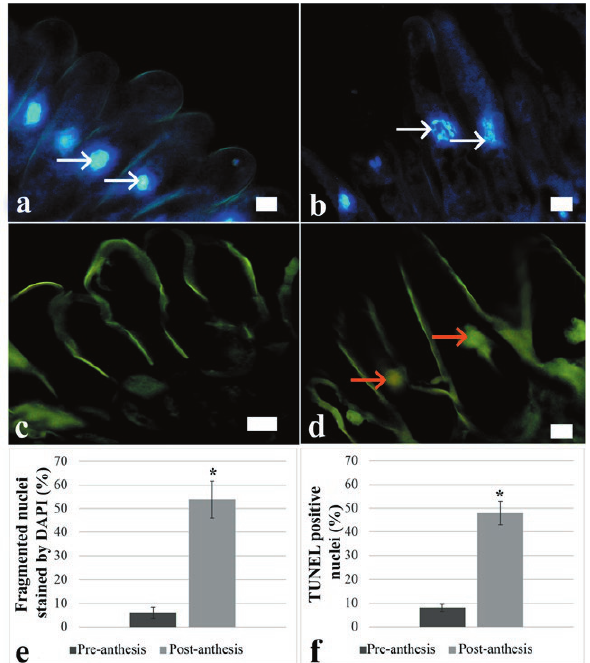
Figure 3. Analysis of nuclear DNA fragmentation. a DAPI stained spherical nuclei at pre-anthesis. b DAPI stained degenerated nuclei at post-anthesis. c TUNEL negative reaction at pre-anthesis. d TUNEL positive reaction at post-anthesis. e DAPI stained frag- mented nuclei rate. f TUNEL positive nuclei rate. White arrows indicate the nuclear morphology and red arrows indicate the TUNEL positive nuclei. Bar: 20